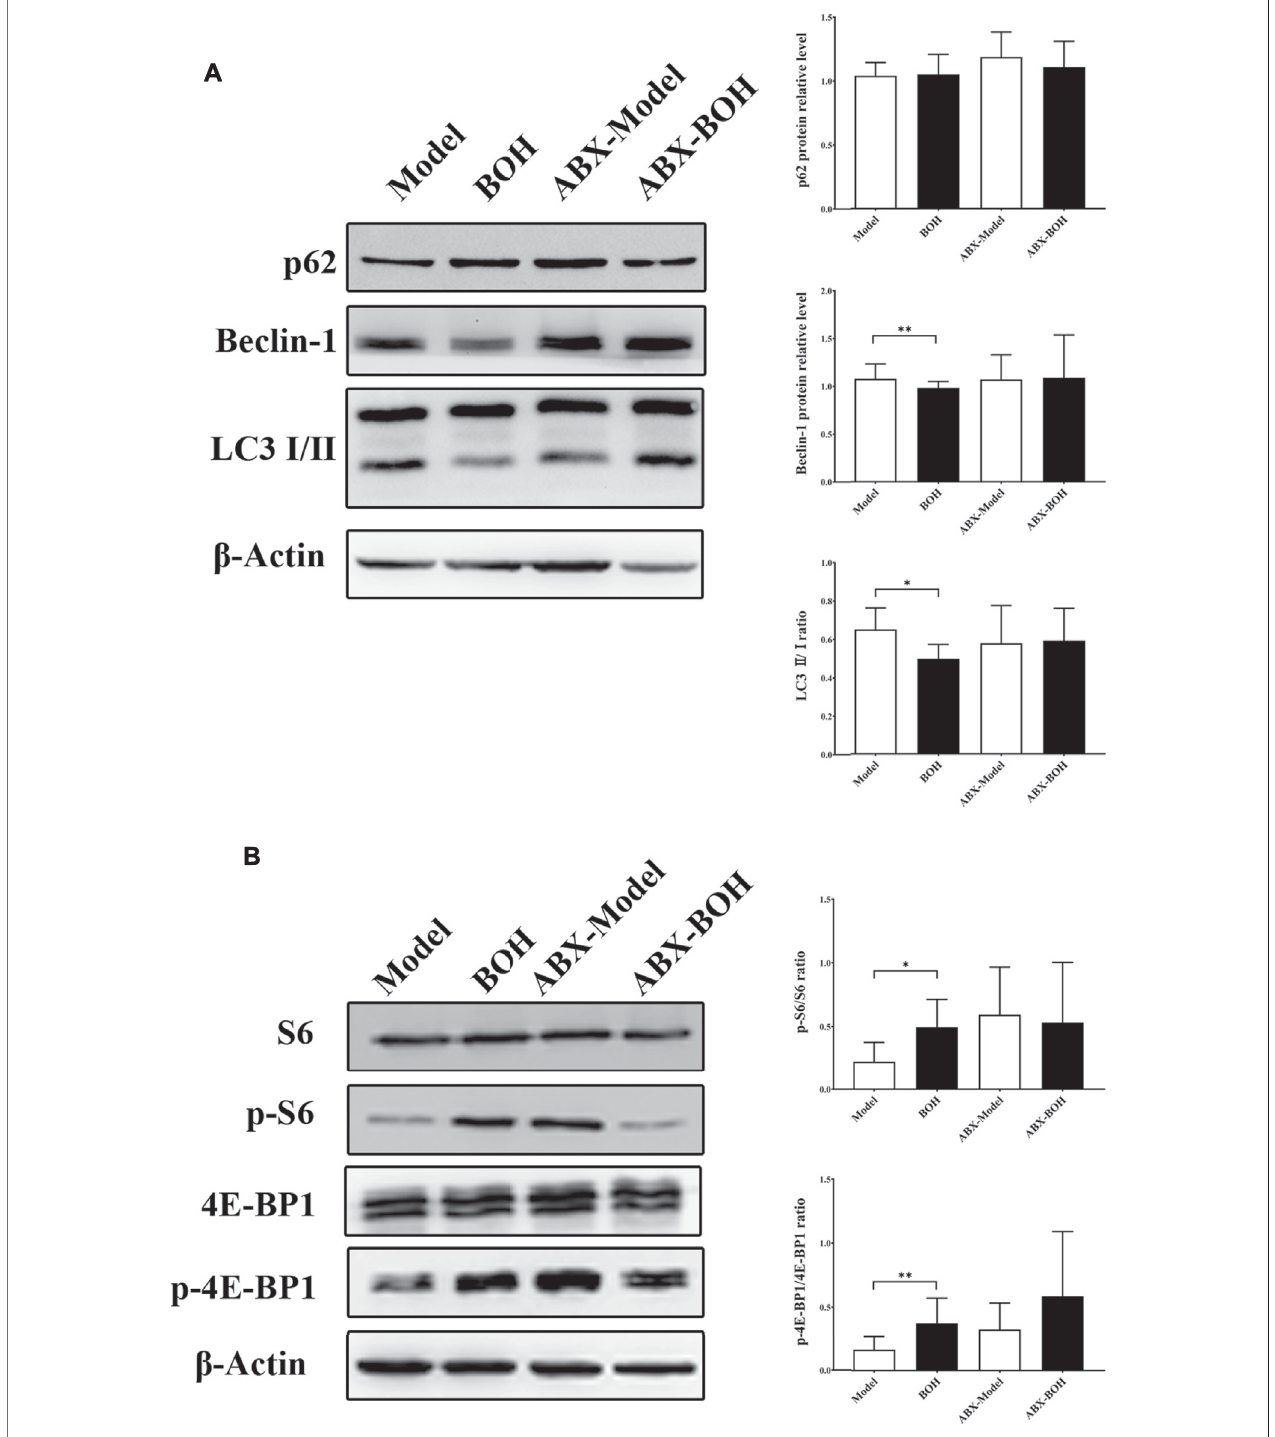
FIGURE 7 | BO activates mTOR as indicated by the phosphorylation of S6 and 4E-BP1. (A) Expressions of autophagy-related proteins under SPF condition and PGF condition. (B) Phosphorylation of S6 and 4E-BP1. n (cid:2) 6. * p < 0.05 and ** p < 0.01.